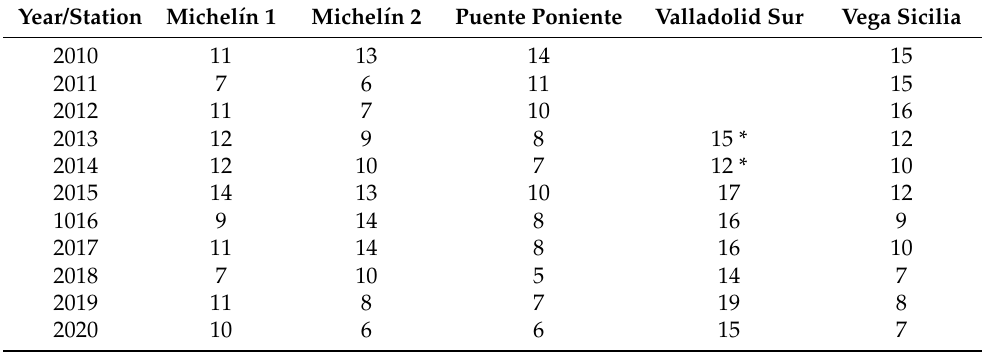
Table 3. Exceedance days of the human threshold value for ozone for each year and measuring site from 2010. (Values with * correspond to the number of days in that